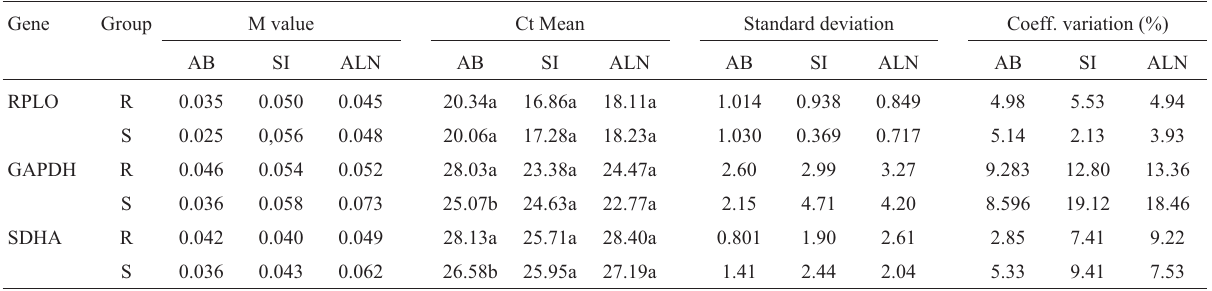
Table 2 - Analysis of RPLO, GAPDH and SDHA reference genes in the abomasum (AB), small intestine (SI) and abomasal lymph nodes (ALN) from re- sistant (R) and susceptible (S) groups. Gene Group M value Ct Mean Standard deviation Coeff. variation (%) AB